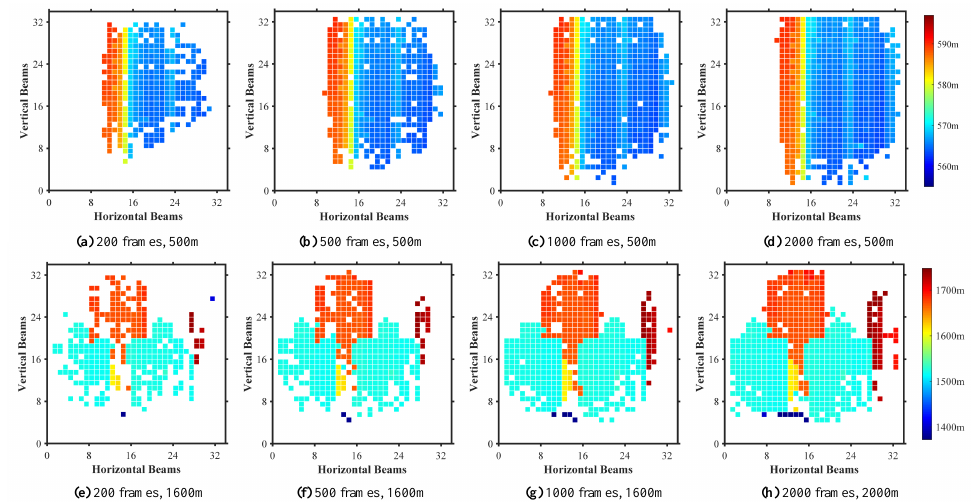
Figure 10. Depth profiles obtained by proposed 3D imaging LiDAR over different frames: ( a – d ) show results from case 1 (200, 500, 1000 m and 2000 frames, corresponding to acquisition times of 40, 100, 200, and 400 ms, respectively). Similarly, ( e – h ) show corresponding results for case 2.